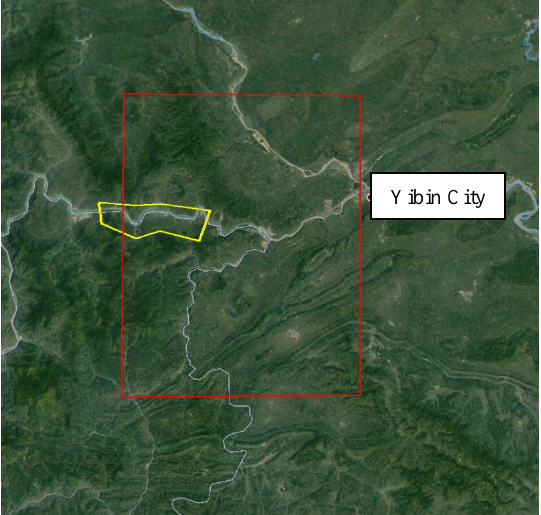
Figure 1. Data coverage (Red rectangle is the data coverage area, yellow area is the transmission